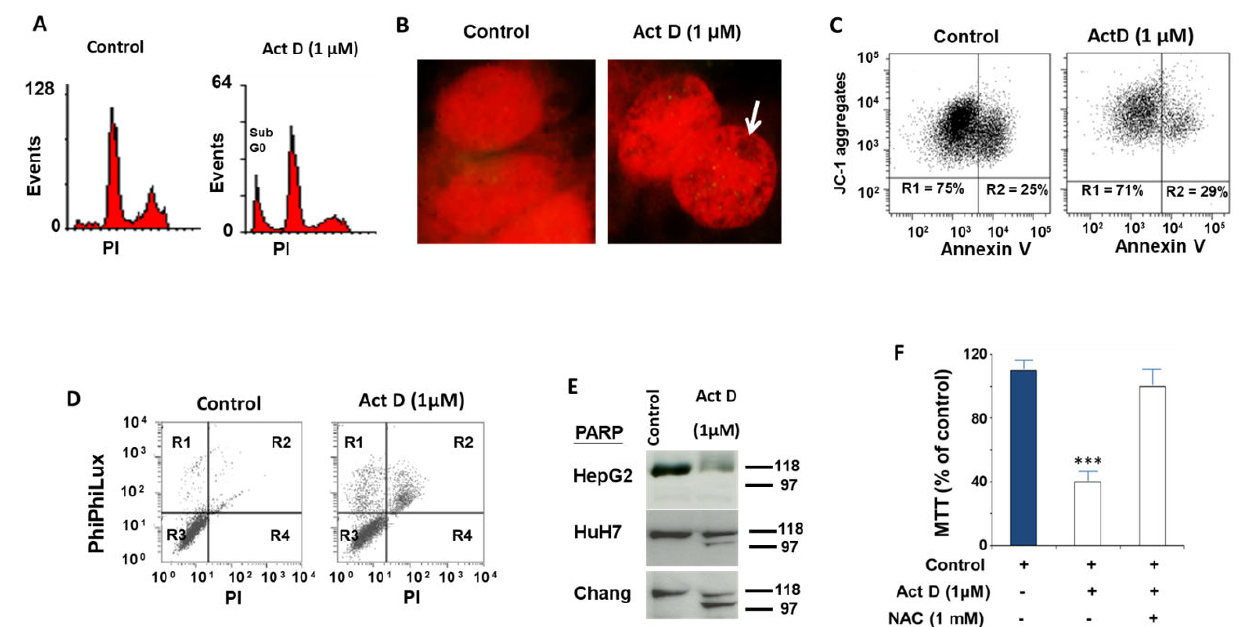
Figure 2. ( A ) Cell cycle analysis by flow cytometry using propidium iodide staining. The sub-G0 population of HepG2 cells treated for 24 h with ActD (1 µ M) in the presence of FBS (5%) increased 3-fold with respect to the control cells (5% FBS). The experiment is representative of three others with similar results. ( B ) Microscopic analysis of the nucleus stained with propidium iodide of the HepG2 cell incubated as explained in panel ( A ), 20 × ( C ). Study by flow cytometry of the binding of Annexin V to the cell surface of live cells measured using a JC-1 probe. HepG2 cells were incubated as explained in panel ( A ). The experiment is representative of three others with similar results. ( D ) Study of caspase 3 activation by flow cytometry using a PhiPhilux probe. A HepG2 cell incubated as explained in panel ( A ). The experiment is representative of three others with similar results. ( E ) Analysis of PARP proteolysis using western blot in different HCC cell lines treated as explained in panel ( A ). The experiment is representative of three others with similar results. ( F ) Measurement of the MTT reducing ability of HepG2 cells in control conditions (5% FBS), in the presence of NAC ( N -Acetyl-L-cysteine) (1 mM) plus ActD (1 µ M) or with ActD (1 µ M) for 24 h. Significance levels: *** p <